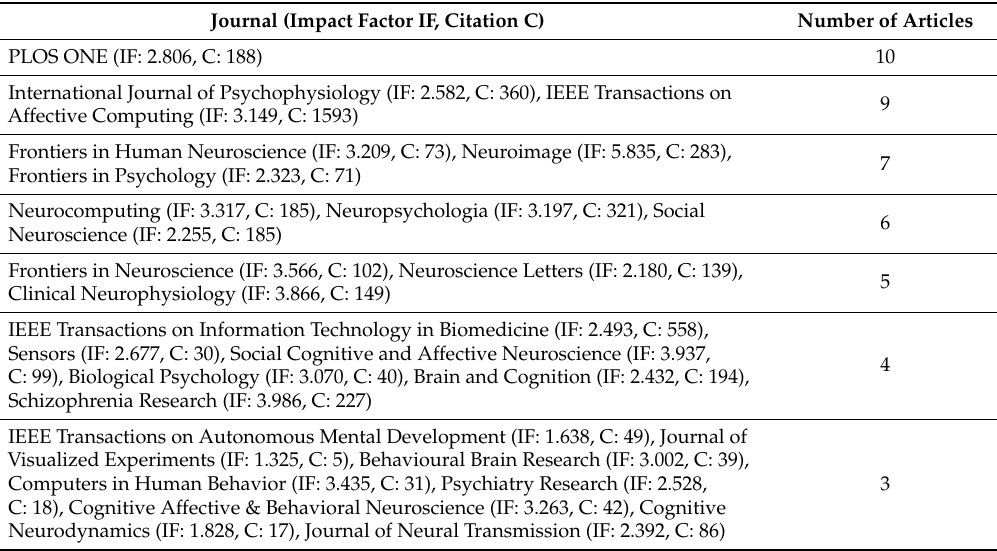
Table A3. Classification of articles based on the